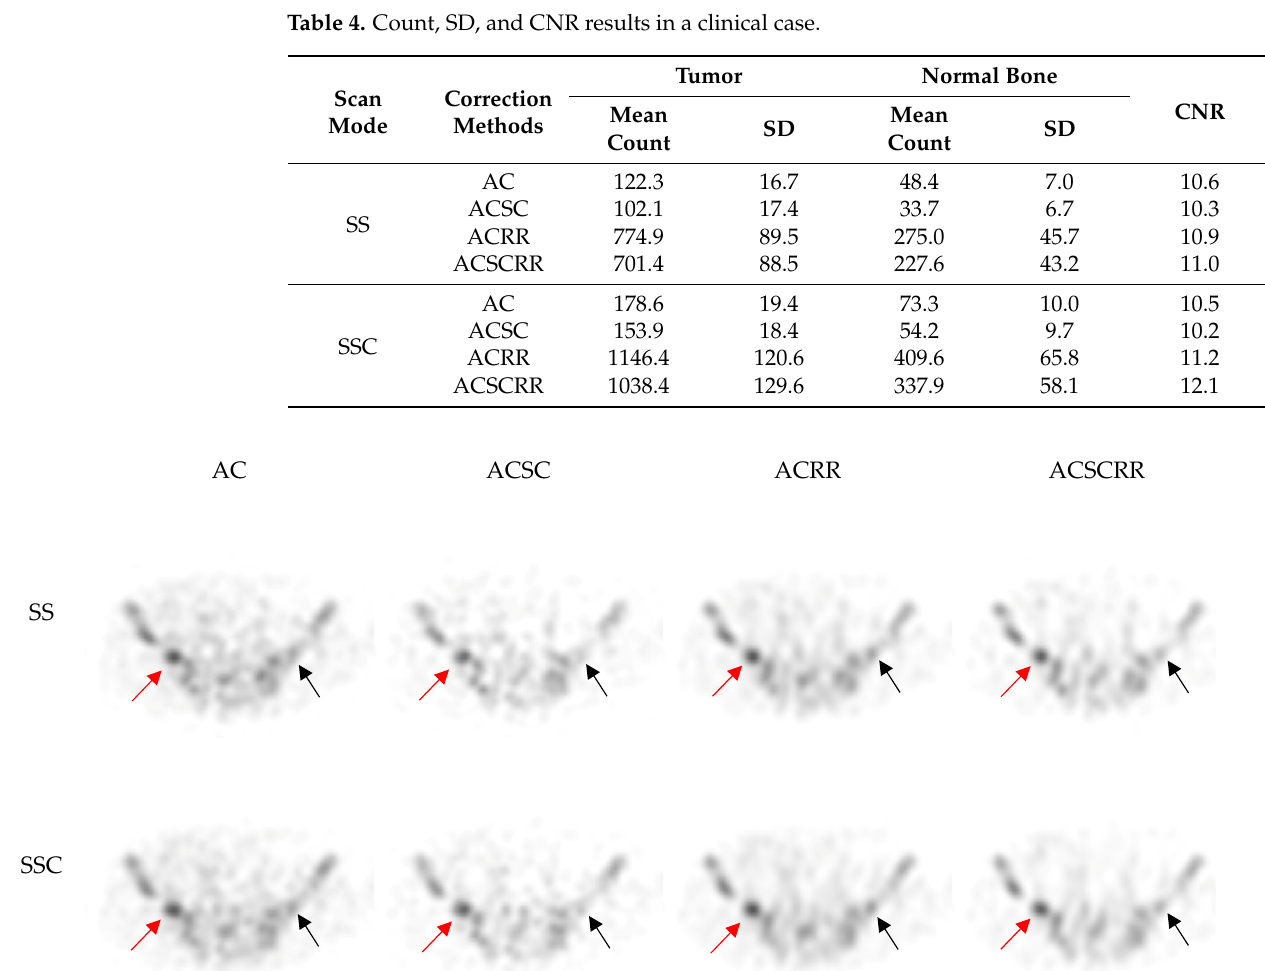
Figure 5. Phantom images for the combination of scan modes and correction methods. The upper and lower window levels were set to 100% and 0%, respectively.